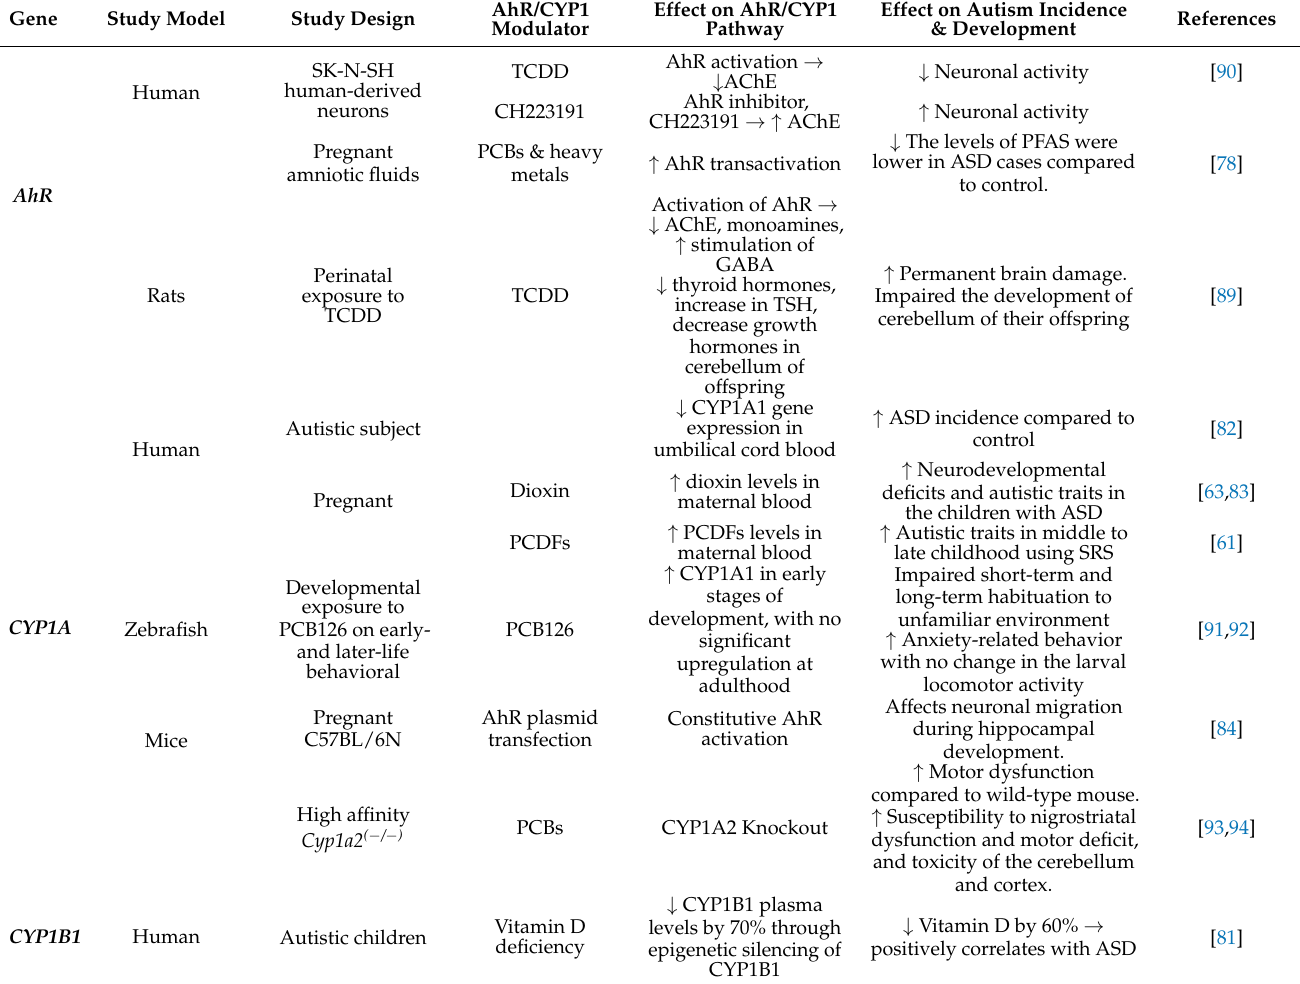
Table 1. The role and mechanisms of AhR/CYP1 pathway in ASD